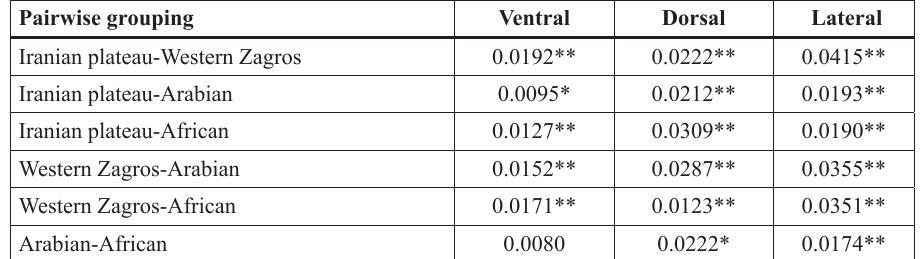
Table 3. Euclidean distances between the Meriones crassus group mean shapes obtained from the Monte Carlo pairwise comparisons (*p < 0.01, **p < 0.001).